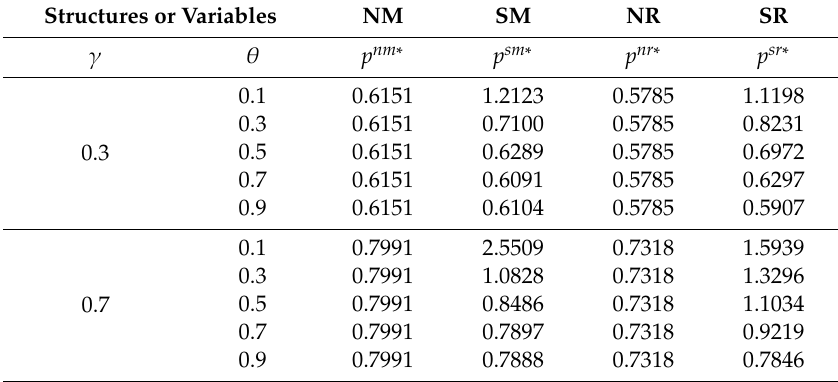
Table 5. The influence of sharing ratios on the selling price under four modes (Unit: USD). Structures or Variables